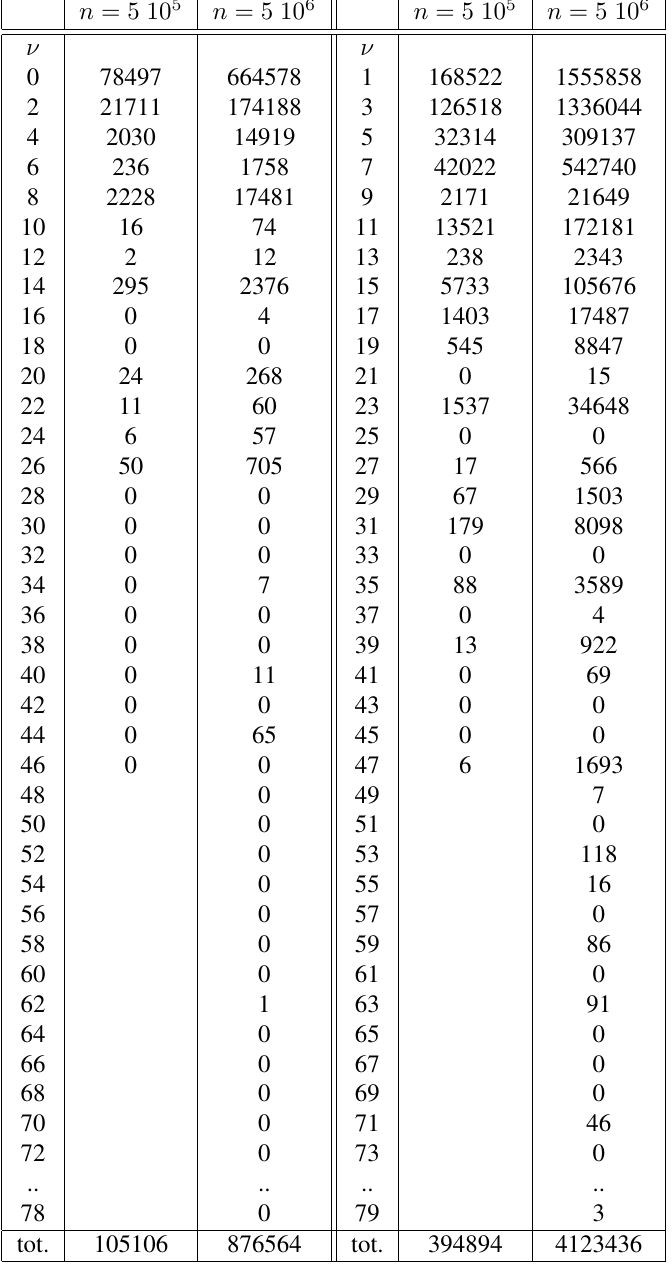
( ν ) of odd integers ≤ 2 n + 1 , with ν couples of divisors, n = 143 for n = 5 10 7 , this case is not reported n